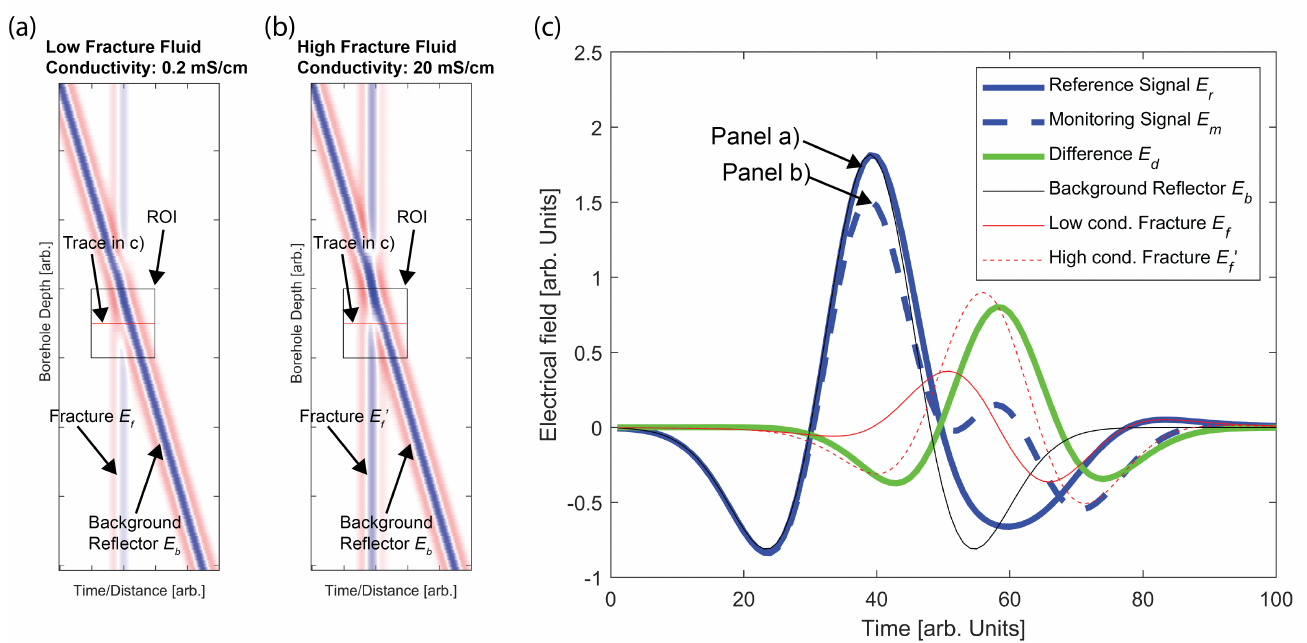
Figure 1. ( a ) Synthetic response for a thin-bed fracture ( E f , with a conductivity 0.2mS/cm) and an additional background reflector ( E b ). The box shows the region of interest (ROI), and the trace that is presented in ( c ). ( b ) Shows the ground penetrating radar (GPR) response for an increased electrical conductivity of the fracture fluid to 20mS/cm ( E (cid:48) GPR traces within the ROI, marked in ( a , b ). The reference trace ( E r , solid blue) corresponds to panel ( a ) and the monitoring trace ( E m , dashed blue) to panel ( b ). The data difference E m − E r is shown in green. Additionally, the signals expected from solely the background reflector (black) and the fracture (red low conductivity, dashed red high conductivity) are plotted. Note that the horizontal axis in ( a , b ) and the horizontal axis in ( c ) represent time ( E r , m ( t ) ), but assuming a constant velocity model, this can be interpreted as the radial distance from the